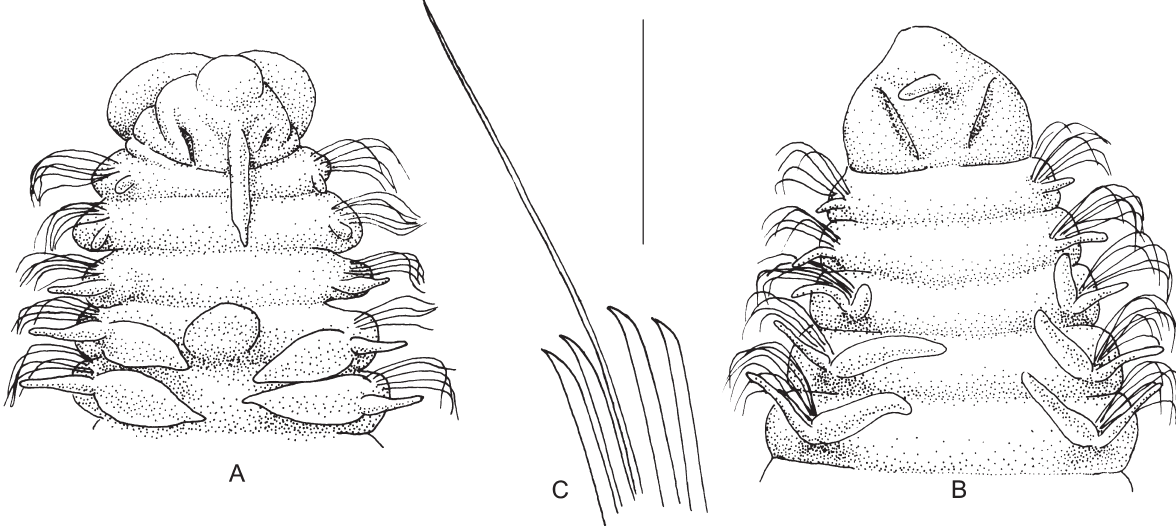
Fig . 21. – Aricidea ( Allia ) claudiae : A, anterior region, dorsal view. Aricidea ( Acmira ) simonae : b, anterior region, dorsal view; c, modified ventral chaetae, chaetiger 43. Scale bar: A 295 µ m; b 355 µ m; c 65 µ